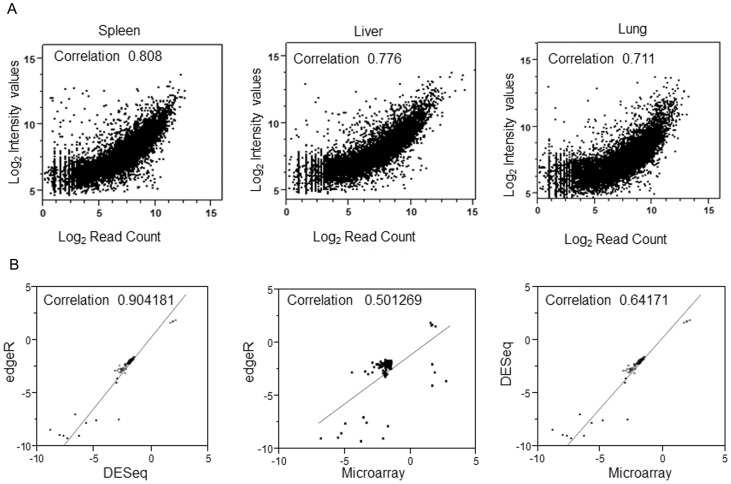
Correlations of microarray and mRNA-Seq and their DE analytic methods.(A) Correlation of signal intensity of saline treated 9V/null tissues in microarray platform with mRNA-Seq platforms. The panels show the (Log2) mRNA-Seq read counts for each gene plotted on the X-axis compared with the (Log2) intensities from the microarray data on the Y-axis. To avoid log of 0, 1 was added to each of the average counts prior to taking logs. The Pearson's coefficients (at the top of each panel) for each tissue show high correlation between the microarray and mRNA-Seq data. (B) Correlations of three DE analytic methods. edgeR and DESeq for mRNA-Seq and Mixed Model ANOVA for microarray were employed to pick a common subsets of genes from mRNA-Seq and microarray platforms. The genes that met the cut-off criteria (FDR  = 0.05, and a FC ≥ ±1.5) by all three DE methods were interrogated.